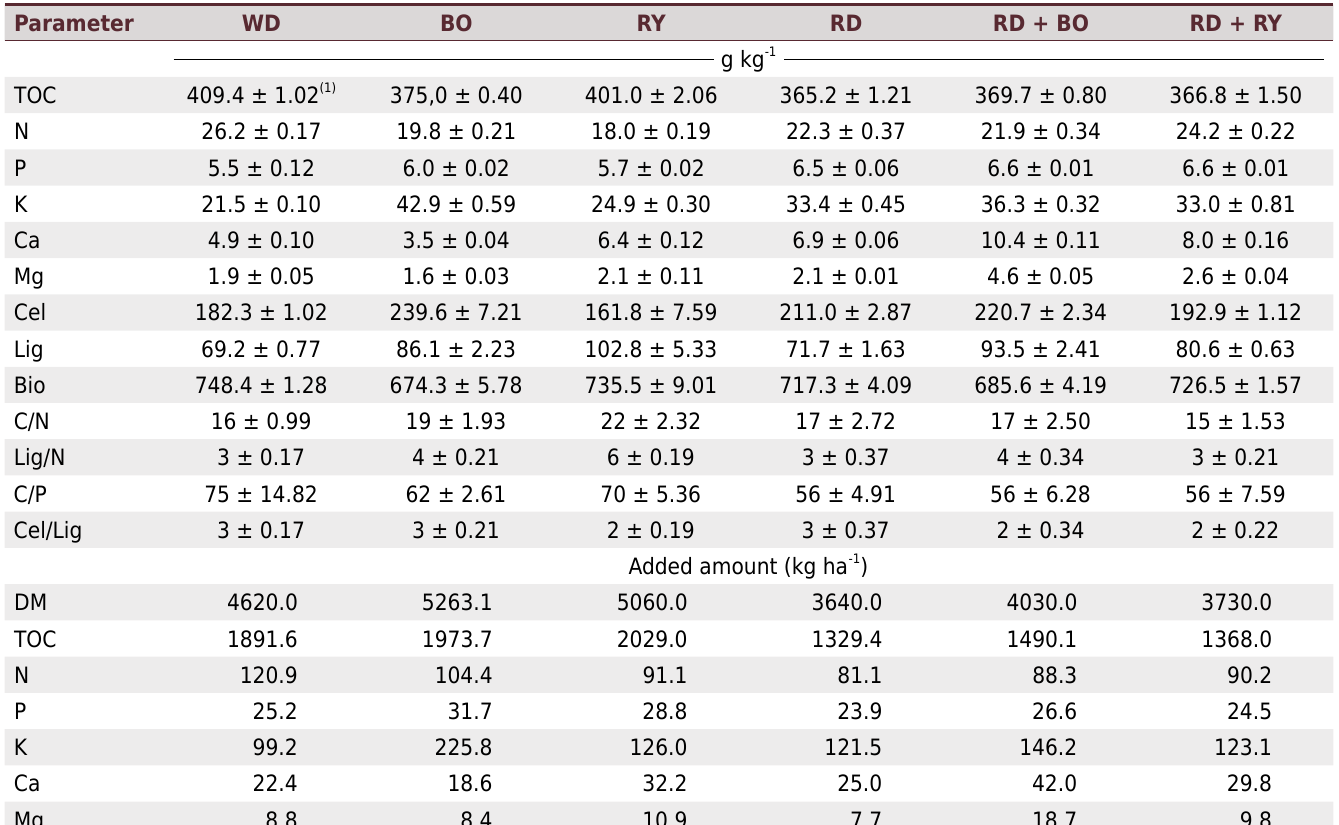
Table 1. Initial chemical characterization of weed (WD), black oat (BO), rye (RY), oilseed radish (RD), oilseed radish + black oat (RD + BO), and oilseed radish + rye (RD + RY) residues and added amounts of dry matter and nutrients